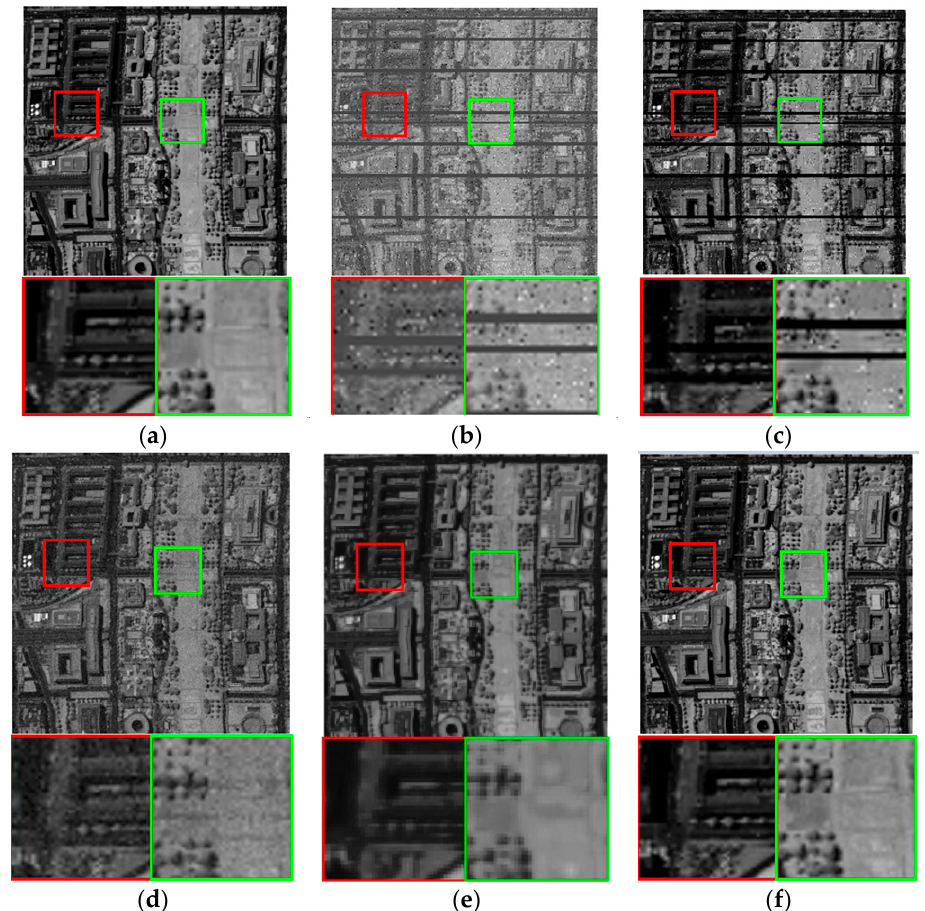
Figure 5. Visual comparison on band 70 of Washington dataset: ( a ) Clean/noise-free image band, ( b ) Noisy band, ( c ) Restoration result from VBM3D, ( d ) Restoration result from Godec, ( e ) Restoration result from SLrank, ( f ) Restoration result from the proposed method.